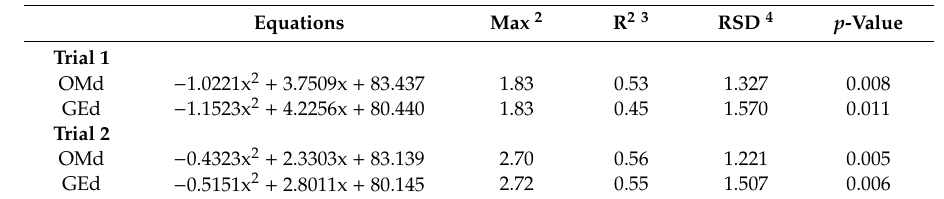
Table4. Regressionequationsshowingtherelationbetweendilutionrate(X)anddigestibilitycoe ffi cients (Y) 1